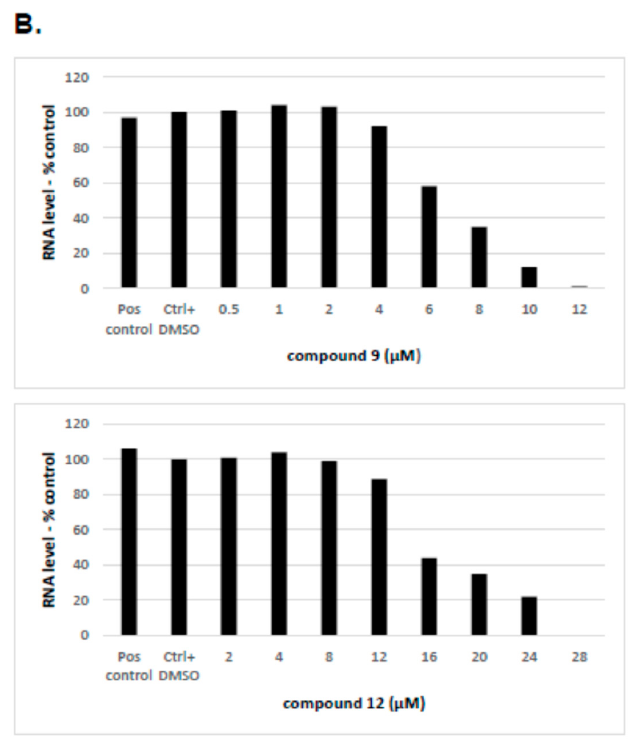
Figure 5. Effect of compounds 9 and 12 on viral RNA synthesis. ( A ) Overnight-grown Huh7.5 cells were infected with hepatitis C virus (HCV) for 4 h and washed with phosphate-buffered saline (PBS), and fresh media with different concentrations of compounds were added. Total RNA was isolated after 48 h and subjected to RT-PCR for HCV NS5B gene to detect the inhibition of viral replication. Actin was amplified simultaneously and was loaded as internal control. ( B ) The bar graphs present the densitometric analysis of NS5B level detected in infected Huh-7 cells treated with different doses of compounds, expressed as percentage of NS5B detected in the